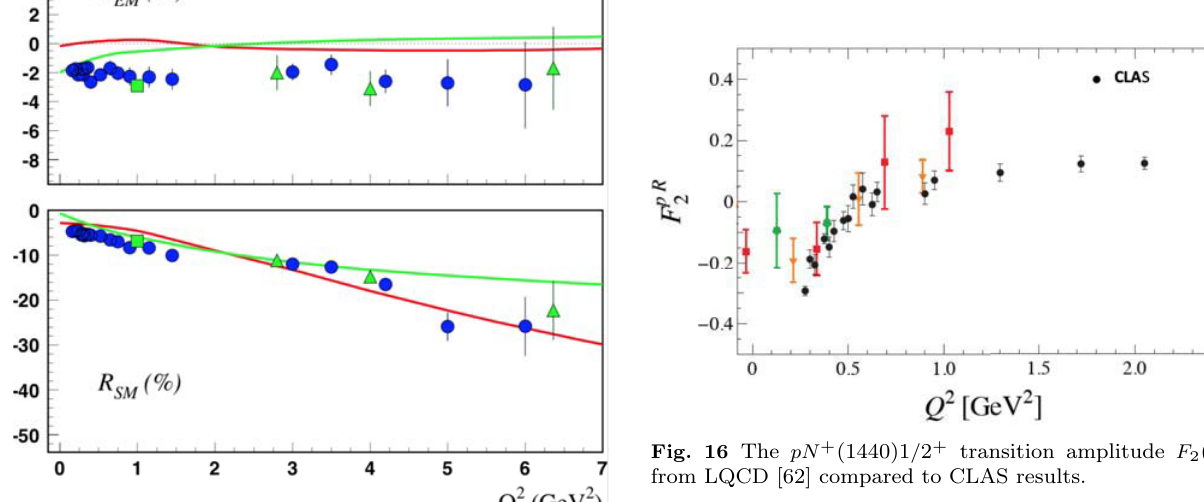
Fig. 15 The transverse helicity amplitudes A 1 / 2 for the Roper resonance N (1440) 1 2+ . Data are from CLAS compared to LF RQM with running quark masses (solid line), and with projections from the DSE/QCD approach (dotted line). The shaded band indicates non 3-quark contributions inferred from the difference of the LF RQM curve and the CLAS data. The red dashed line is the EFT calculation that describes the data at small Q 2 .